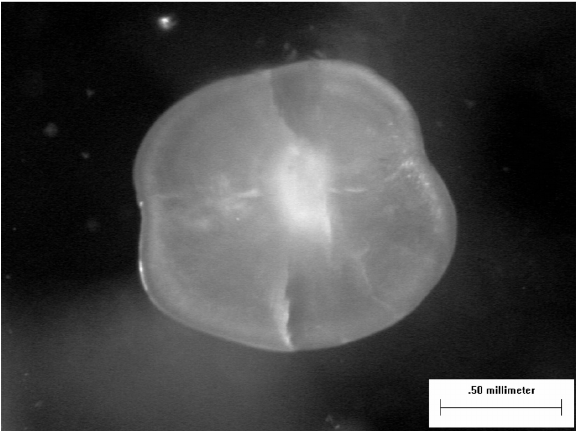
Fig. 7. – Sagittal otolith of Buenia affinis male caught in June (32.2 mm TL), consisting of an opaque nucleus surrounded by a wide translucent band and a rather narrow opaque band close to the mar- gin, both forming one